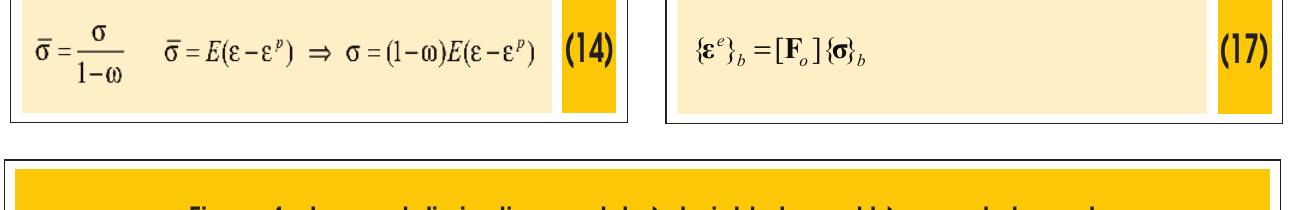
Figure 4 – Lumped dissipation model a) straight element b) curved